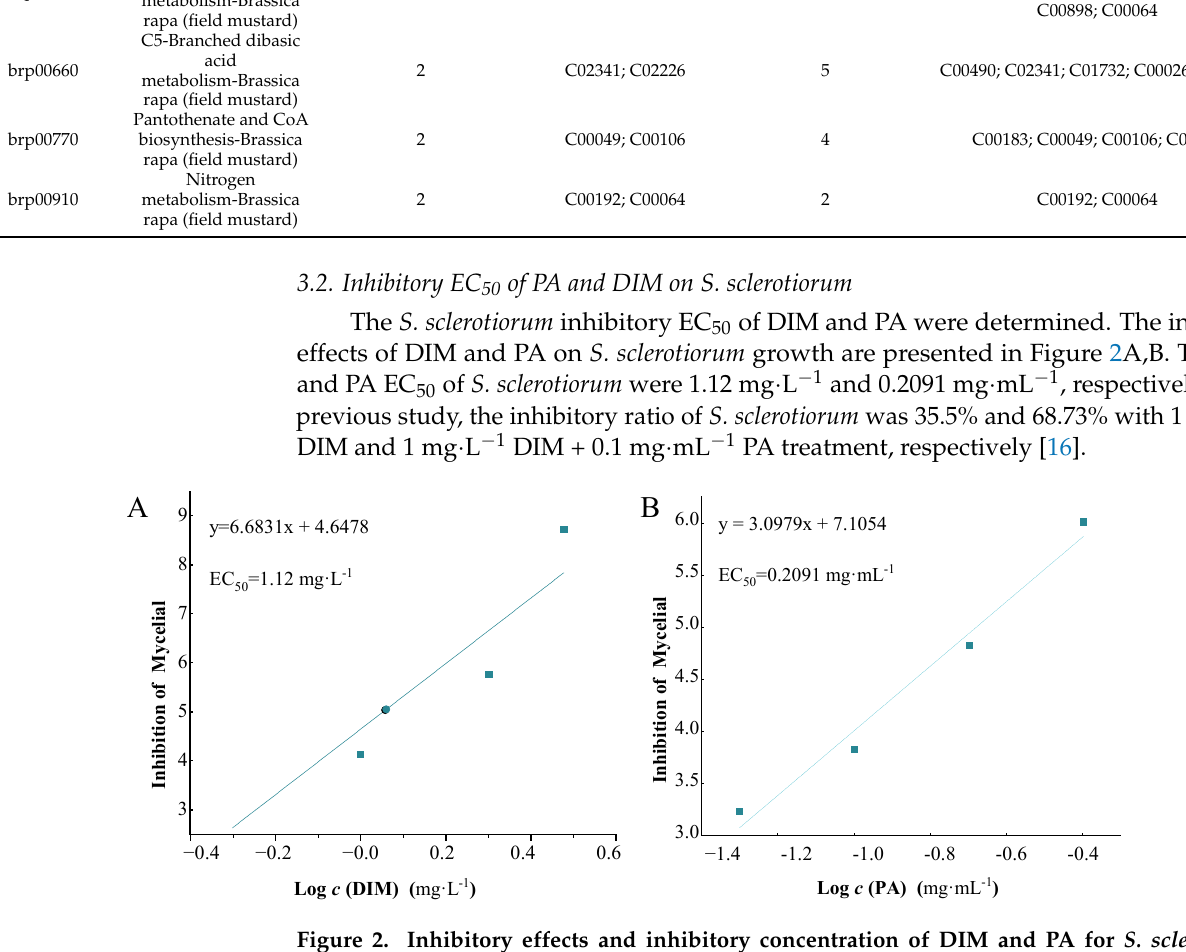
Figure 2. Inhibitory effects and inhibitory concentration of DIM and PA for S. sclerotiorum . ( A ) Baseline of DIM sensitivity to S. sclerotiorum. ( B ) Baseline of PA sensitivity to S. sclerotiorum . Combining with the results of EC 50 , the amount of DIM was reduced; 0.8 mg · L − 1 DIM and 0.1 mg · mL − 1 PA were chosen to investigate the inhibition of S. sclerotiorum